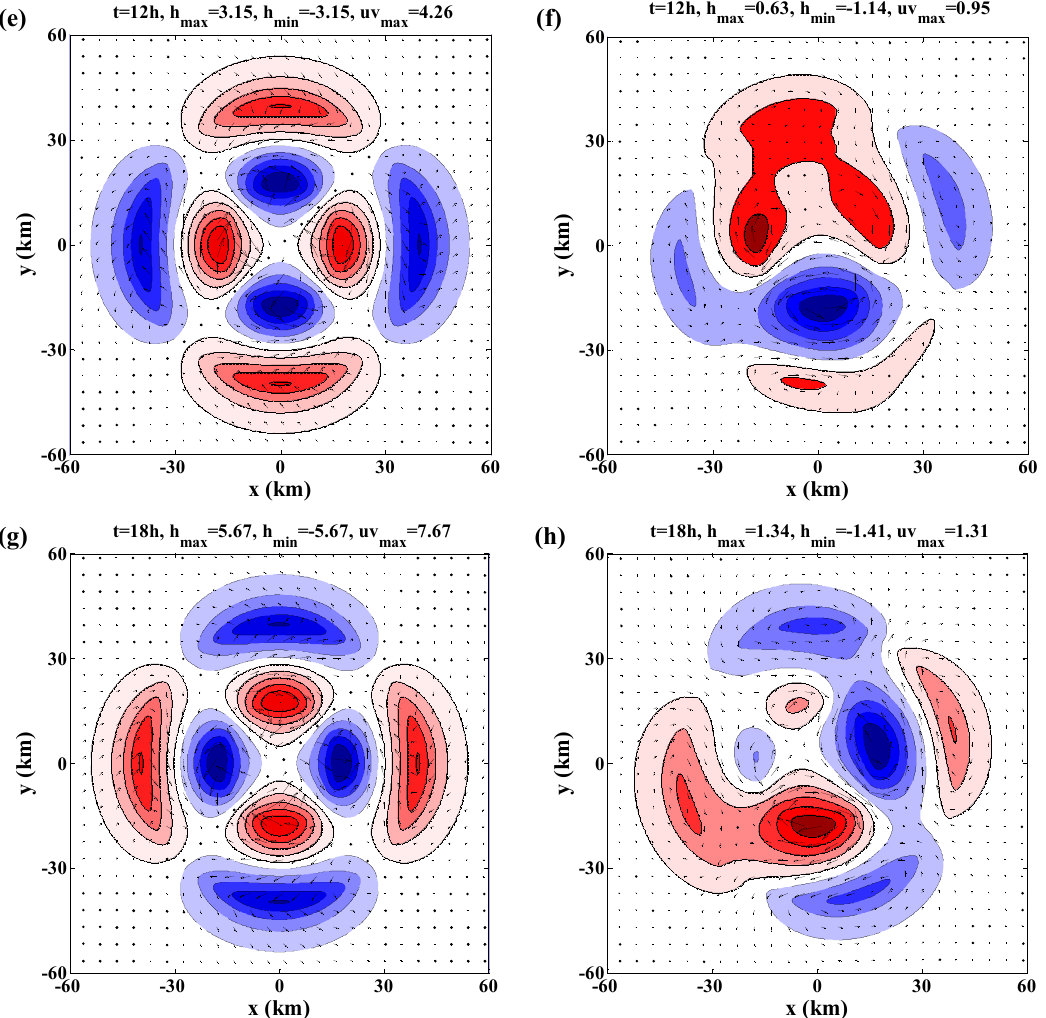
Figure 6. The evolution of perturbation height (m; shaded, red is positive and blue is negative) and horizontal flow vectors (ms − 1 ) obtained from ( a , c , e , g ) the most unstable mode and ( b , d , f , h ) superposition of the numerical integration results for different azimuthal WNs at t = 1 h, t = 6 h, t = 12 h and t = 18 h.